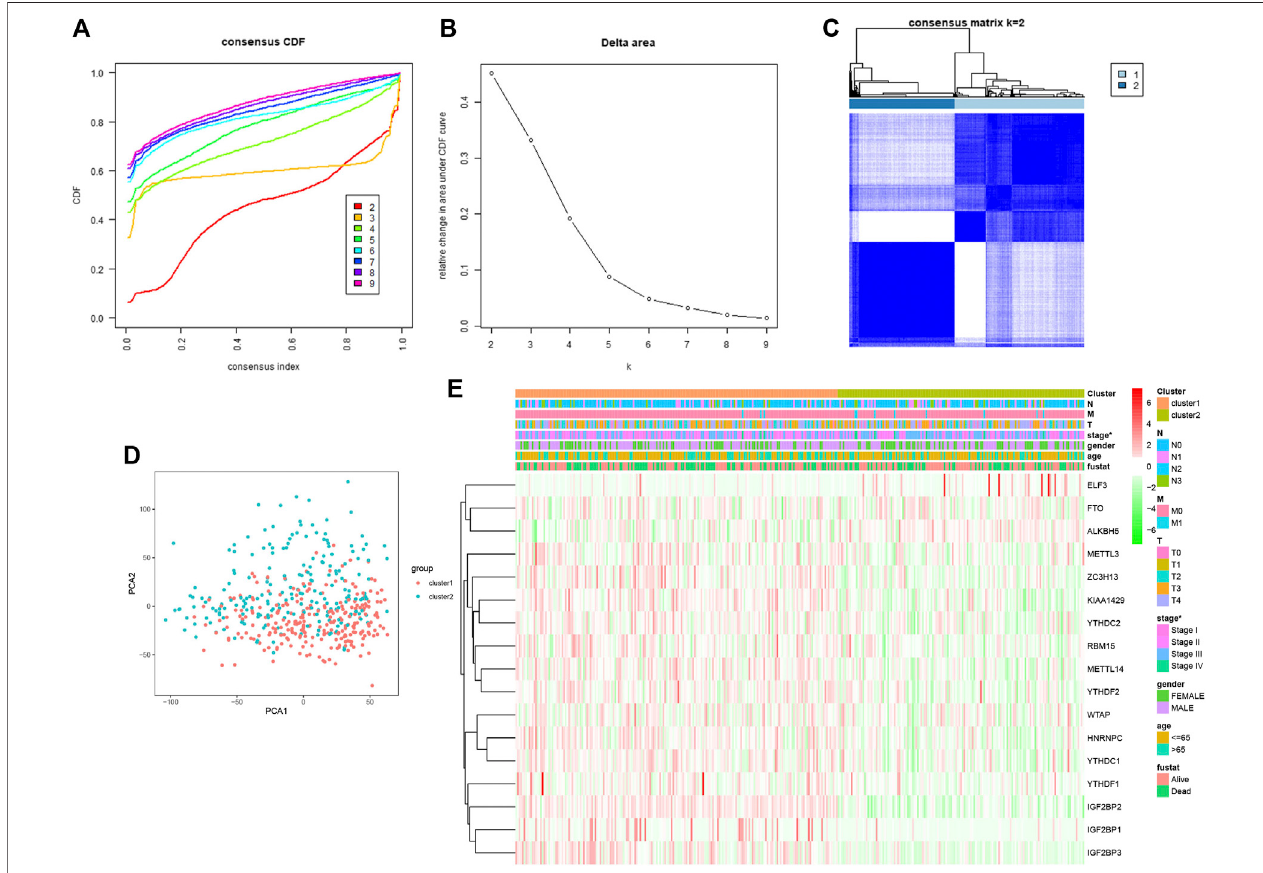
FIGURE 3 | Association between the m 6 A RNA methylation regulators and clinicopathological and prognostic features of melanoma patients. (A) consensus clustering model with cumulation distribution function (CDF) for K (cid:1) 2 – 9 (K means cluster count). (B) Relative change in area under the CDF curve for K (cid:1) 2 – 9. (C) The Cancer G enome Atlas (TCGA) melanoma cohort was classi fi ed into three clusters with K (cid:1) 2. (D) Principal component analysis of the total RNAexpression pro fi le of cluster 1 (red), cluster 2 (blue). (E) The correlation of the two cluster with clinicopathologic features was visualized by heatmap. p < 0.05 ( “ * ” ).